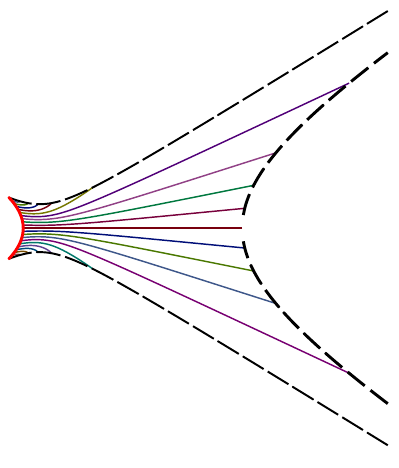
Figure 15 . Radial pro(cid:12)les of extremal surfaces in Kruskal coordinates ( T; X ). Those surfaces emitted from the brane at su(cid:14)ciently late or early times fall into the